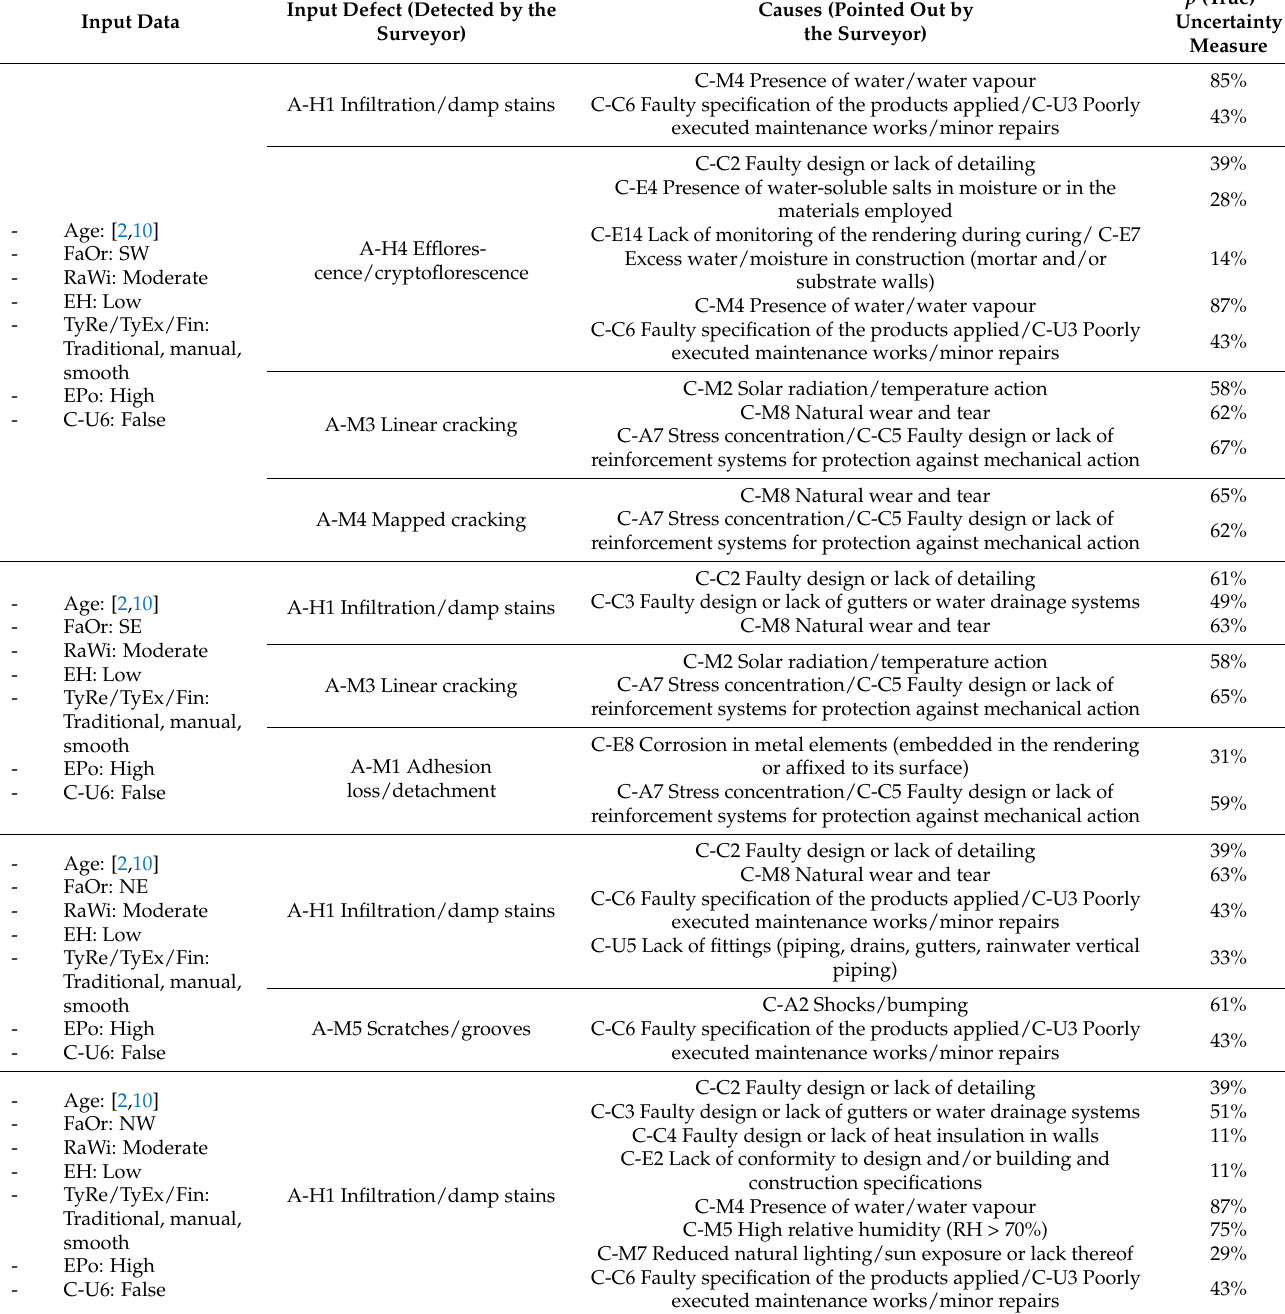
Table 4. Quantification of uncertainty based on the BN model using cases of a sample from the literature [27]. Input